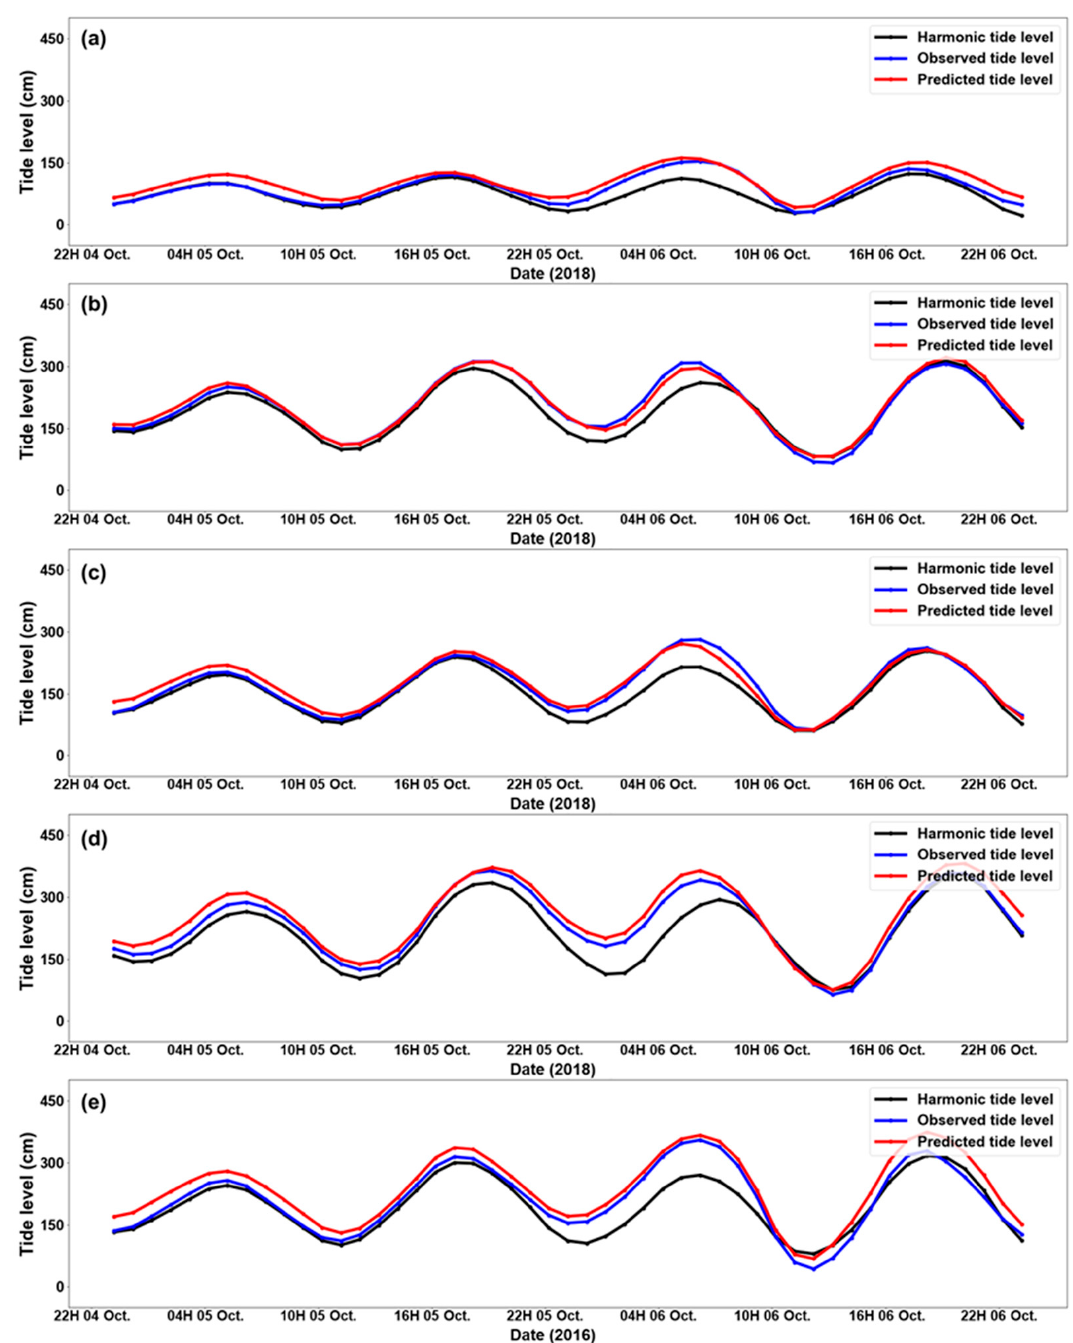
Figure 17. Validation of trained model during Typhoon Kong-Rey (2018). Time-series results for ( a ) Busan, ( b ) Geomundo, ( c ) Tongyeong, ( d ) Wando, and ( e ) Yeosu stations. Red line is results predicted by the trained model. Blue and black lines show observed and harmonic tide levels, respectively, at the tidal station.